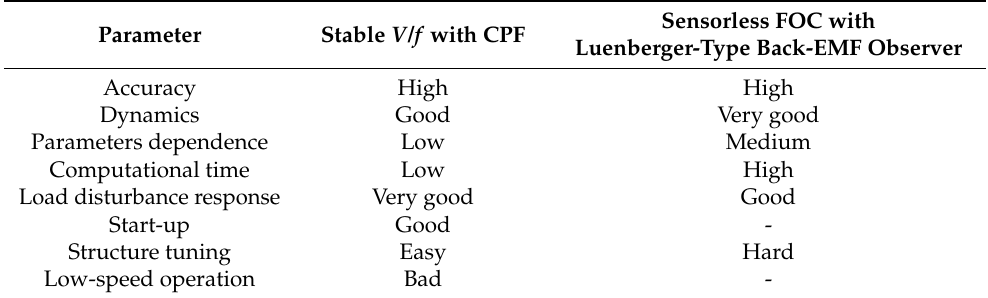
Table 3. Comparison between stable V / f with CPF and sensorless FOC with Luenberger-type back-EMF observer. Sensorless FOC with Parameter Stable V / f with CPF Luenberger-Type Back-EMF Observer Accuracy High High Dynamics Good Very good Parameters dependence Low Medium Computational time Low High Load disturbance response Very good Good Start-up Good - Structure tuning Easy Hard Low-speed operation Bad